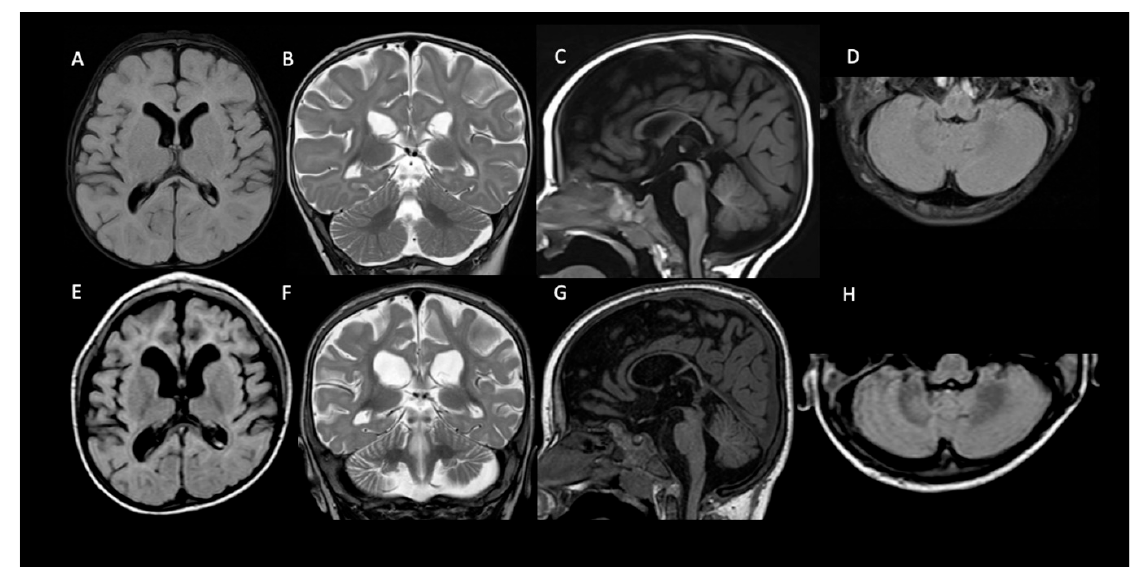
Figure 2. Progressive brain atrophy in patient 1. Compared to brain MRI performed at 6 months of age ( A – D ), MRI performed at 2.5 years of age ( E – H ) show progressive ventricular and CSF enlargement ( E , F ) more prominent in the frontal-temporal regions ( E ) and a widening of the interfolial cerebellar spaces of both cerebellar hemispheres ( G , H ) with a further thinning of the corpus callosum ( G ).